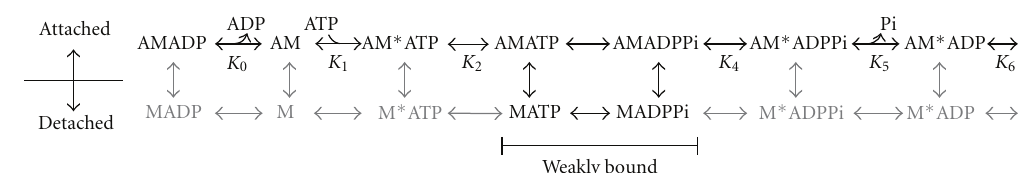
Figure 3: Kinetic model of actomyosin (AM) ATPase. The main pathway is shown in black and the minor pathway in grey. Upper row is in attached state and lower row is in detached state. A: actin; M: myosin. The asterisks show the di ff erence in the conformation of the molecule.